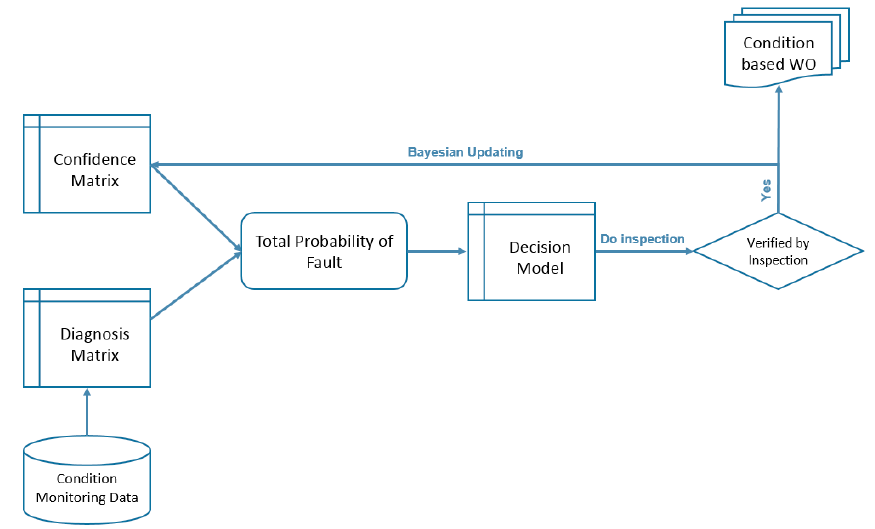
Figure 5. Framework for a diagnostic model with Bayesian updating for offshore wind components.